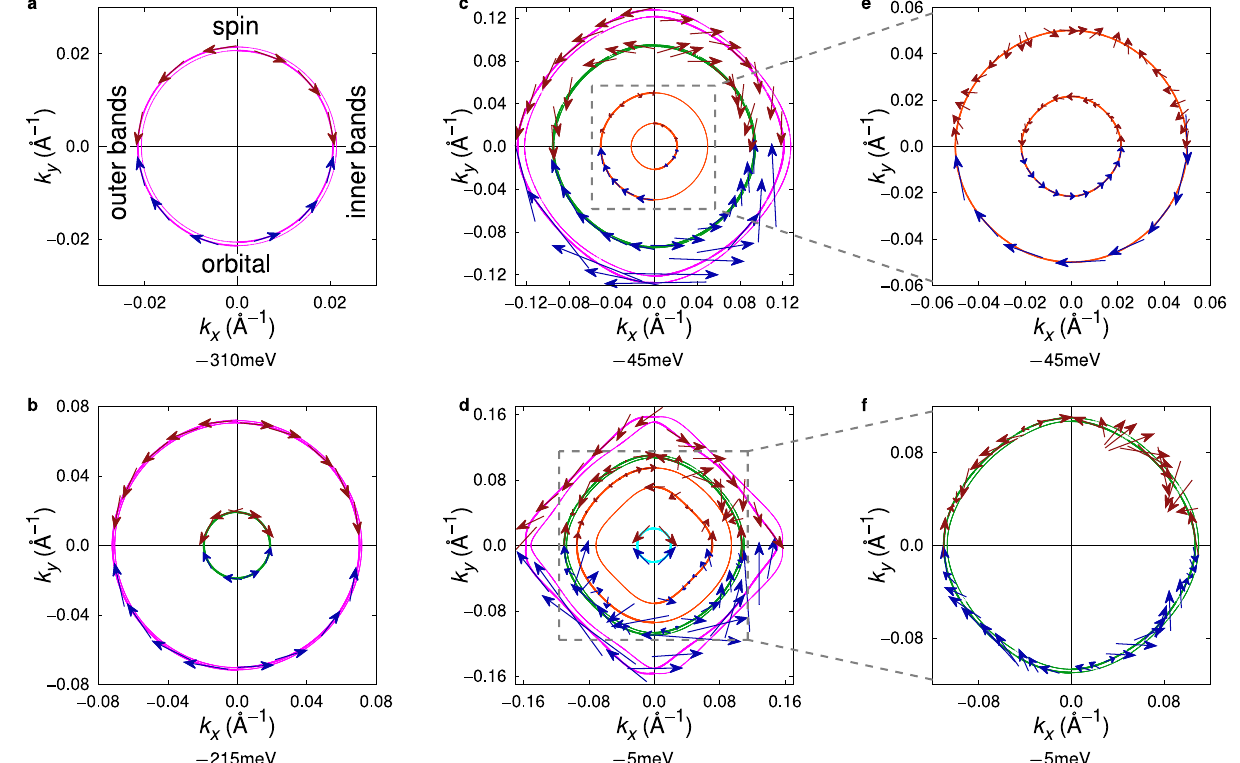
Fig. 2 | Spin and orbital textures of electronic states. Constant energy lines with spin and orbital textures at selected energies. Panels a – d Iso-energy lines slightly above the band edges of the four band pairs. The upper quadrants display the spin texture (red arrows), the lower quadrants the orbital expectation values (blue